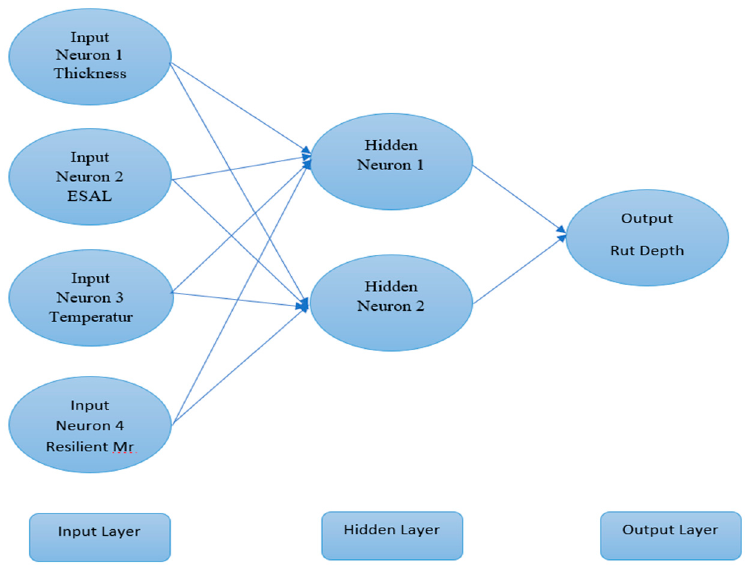
Figure 3. The architecture of the developed ANN Model.